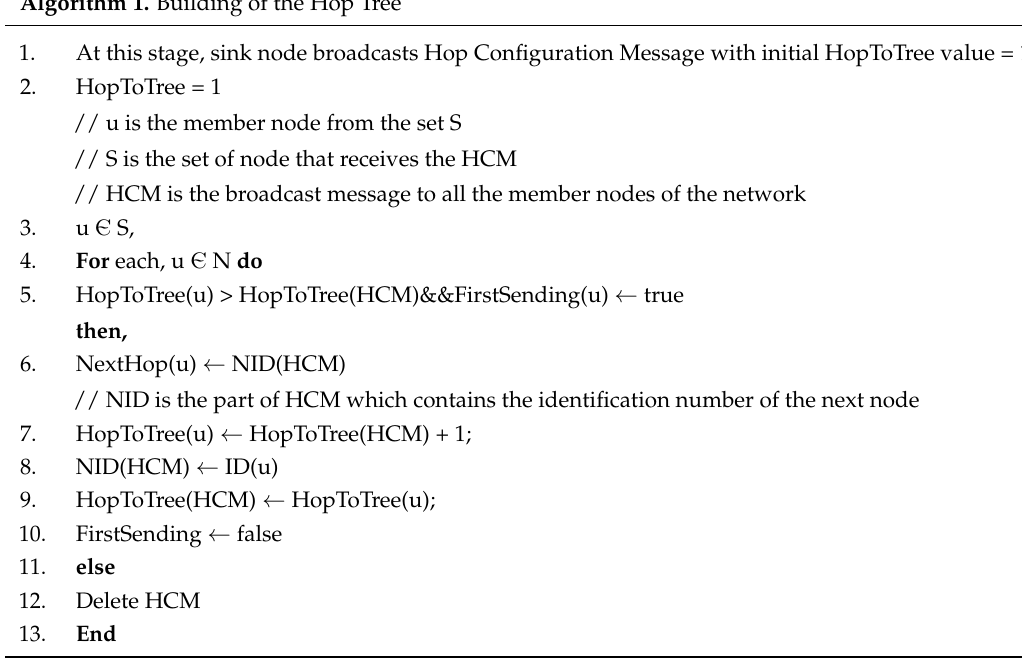
Algorithm 1. Building of the Hop Tree